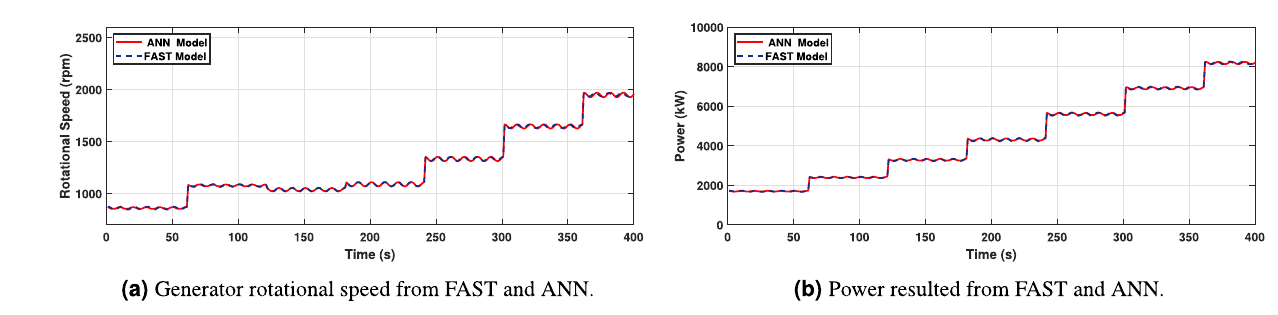
Figure 16. Generator rotational speed and The red curve (solid) corresponds to the ANN-based model and the black curve (dashed) represents the FAST model. For this type of system, a periodic steady-state condition was found by simulating the nonlinear model long enough to dampen out the transient state. Therefore the first 500s of simulations have been omitted to avoid transients. Figure 14a and b correspond to the platform pitch angle and fore-aft displacement. As it may be observed, they reveal that the model has been adequately trained and that there is a high agreement between the values obtained from FAST and the proposed ANN model, with slight differences for non-representative low wind speeds.